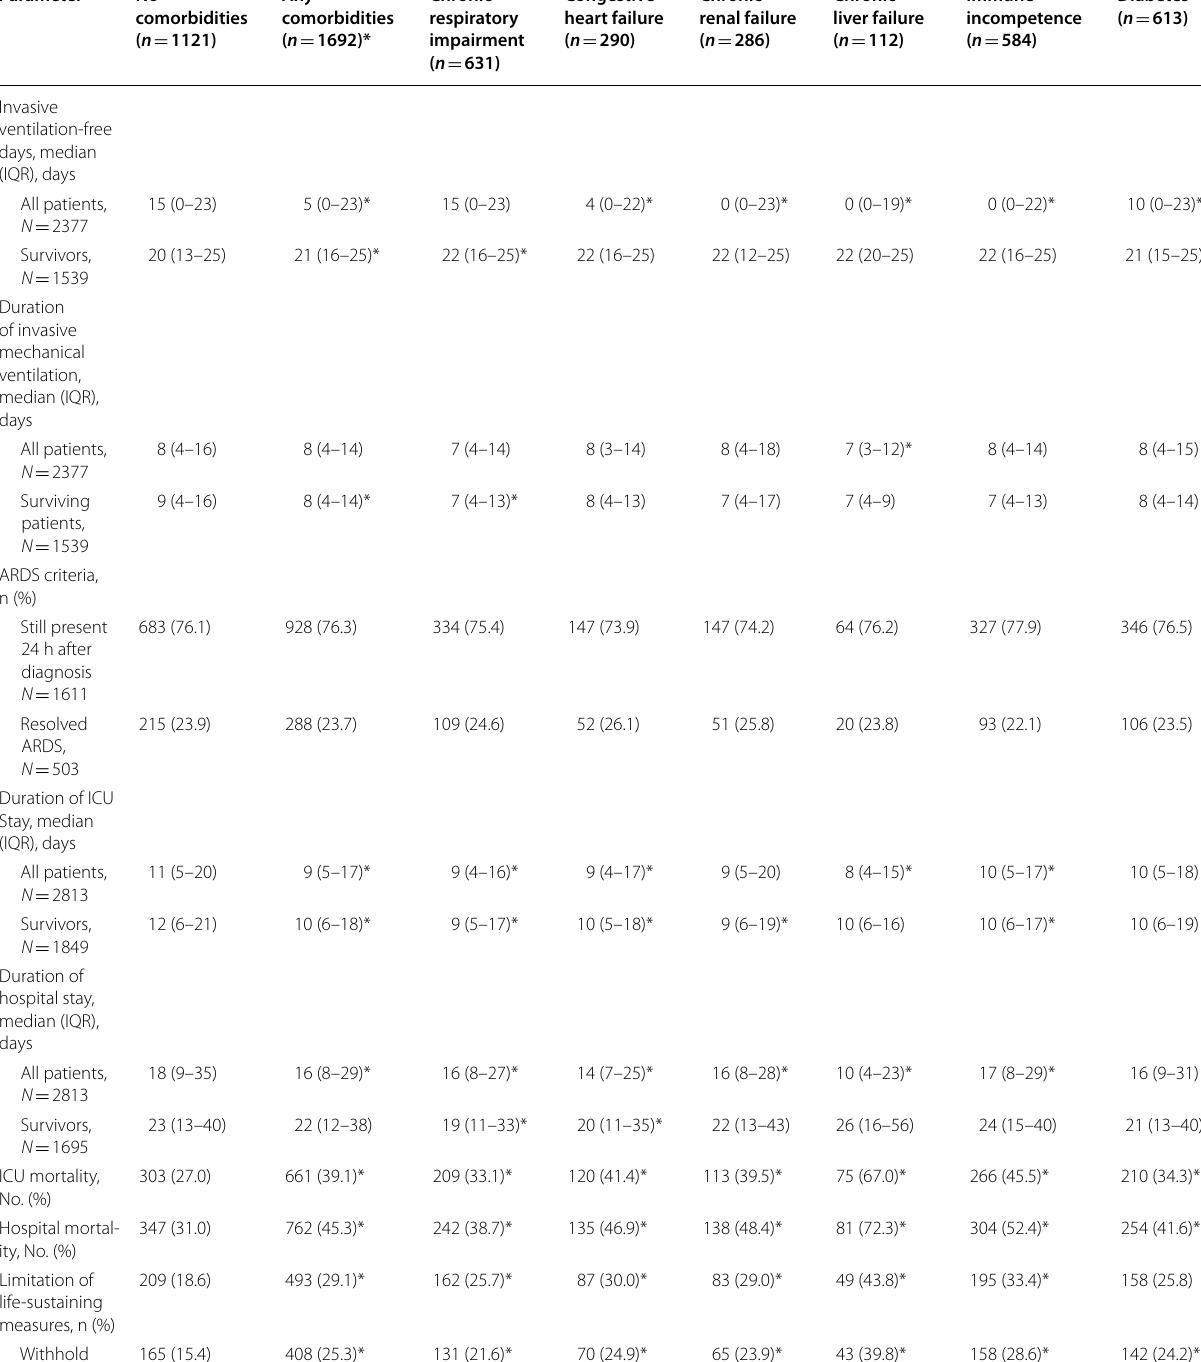
Table 3 Outcomes of patients with ARDS with and without